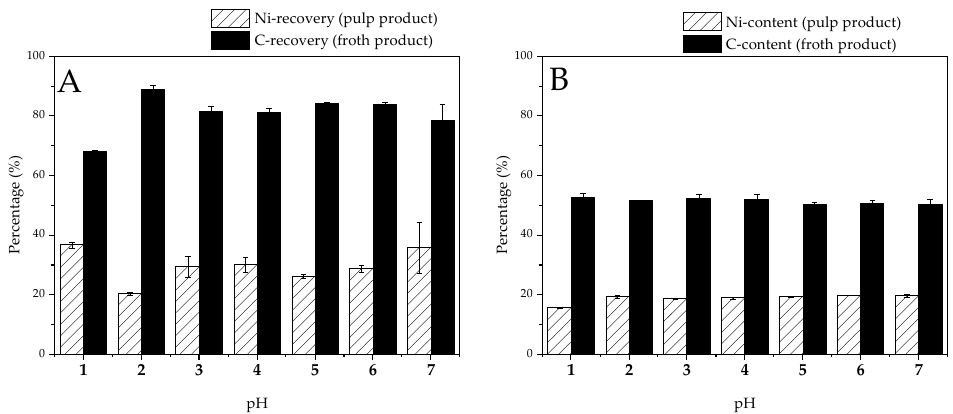
Figure 7. ( A ) Recoveries and ( B ) contents of flotation products obtained from the BM pretreated with F1 solution (0.1 M) at different pH values.